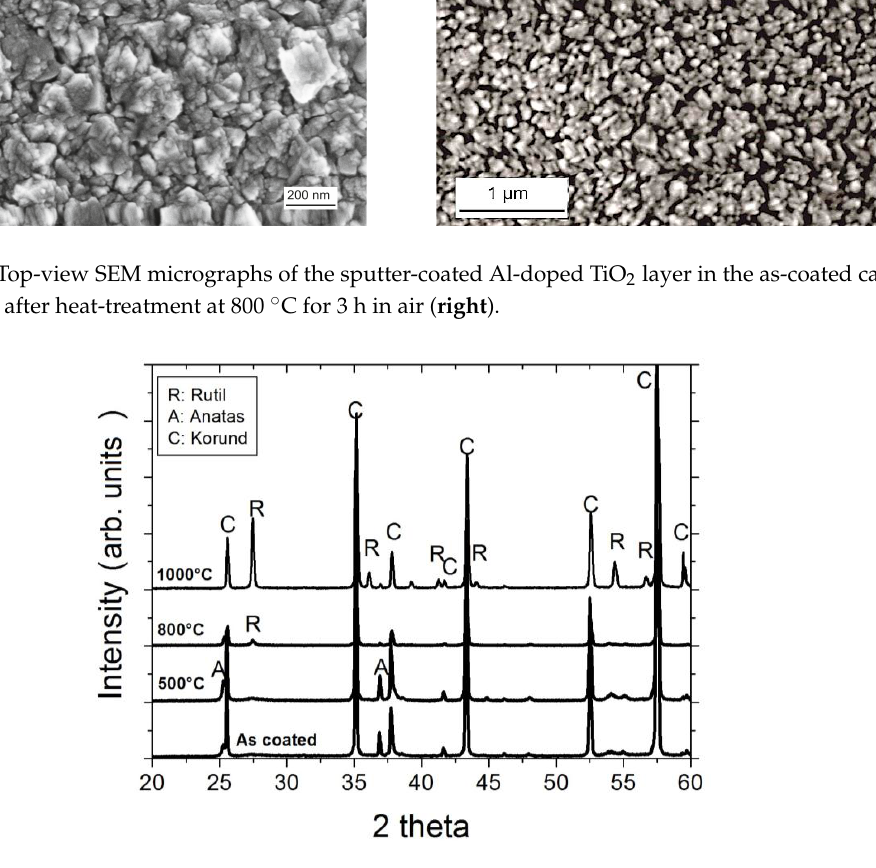
Figure 3. XRD diffractograms of the Al-doped TiO 2 layers deposited by a sputtering process in the as-coated state and ex situ, heat-treated at 500 °C, 800 °C, and 1000 °C.